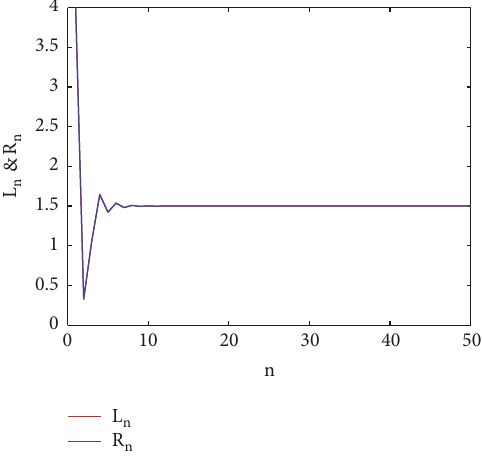
Figure 5: The solution of system (64) at 𝛼 =